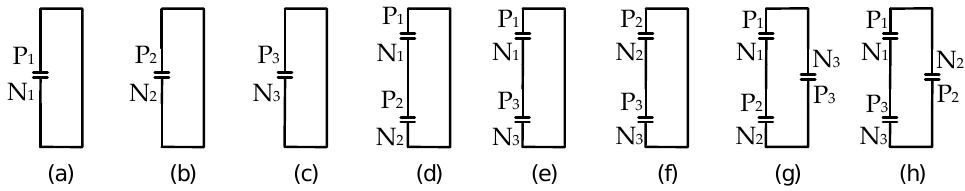
Figure 4. Possible example of one capacitor ( a – c ), two capacitors ( d – f ) and three capacitors ( g , h ) interconnections